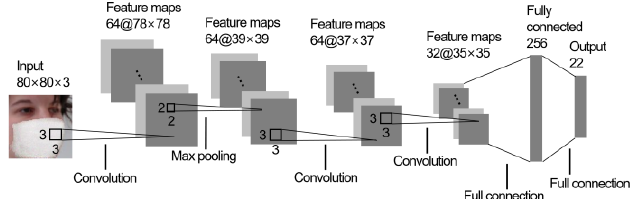
Figure 8. The CNN classifier used for measuring the FR rates. A face image of 80 × 80 pixels was used as an input image in this figure.